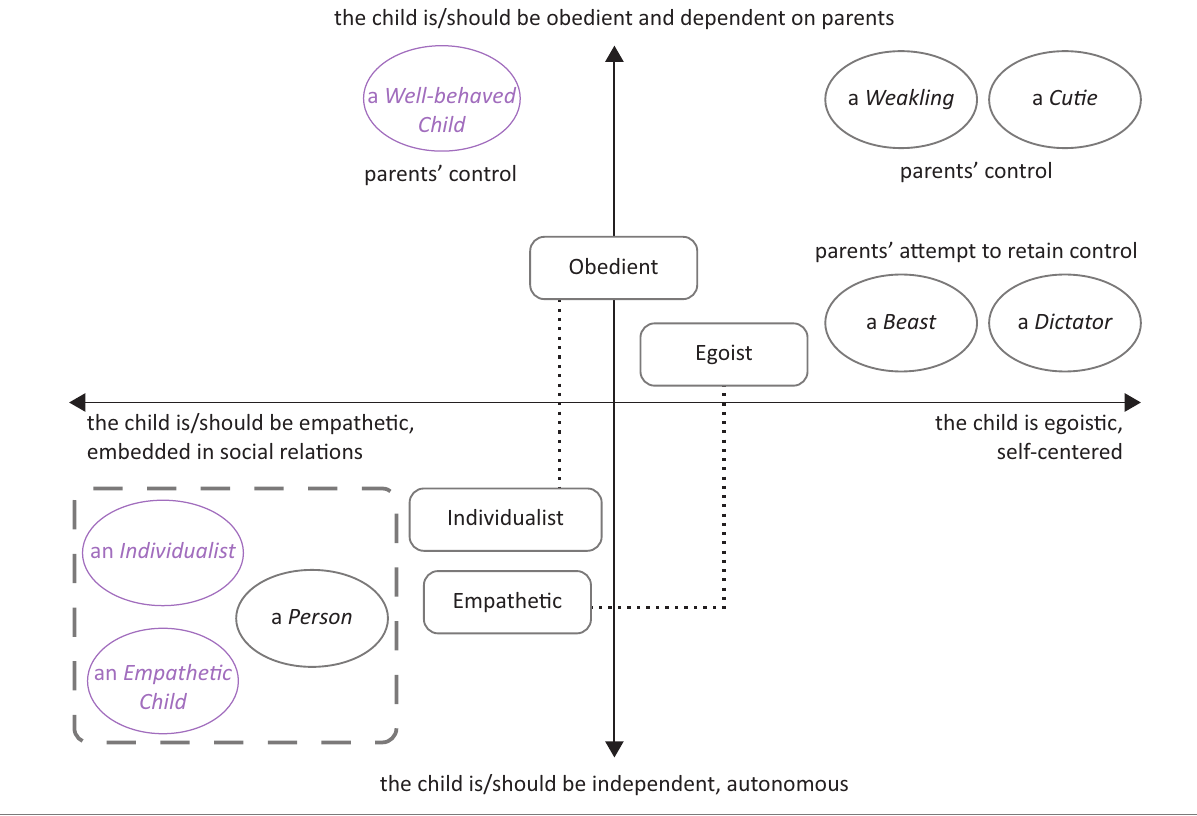
Figure 1. Two dimensions of contradictions between daily family practices with the actual children and parents’ normative images of a perfect